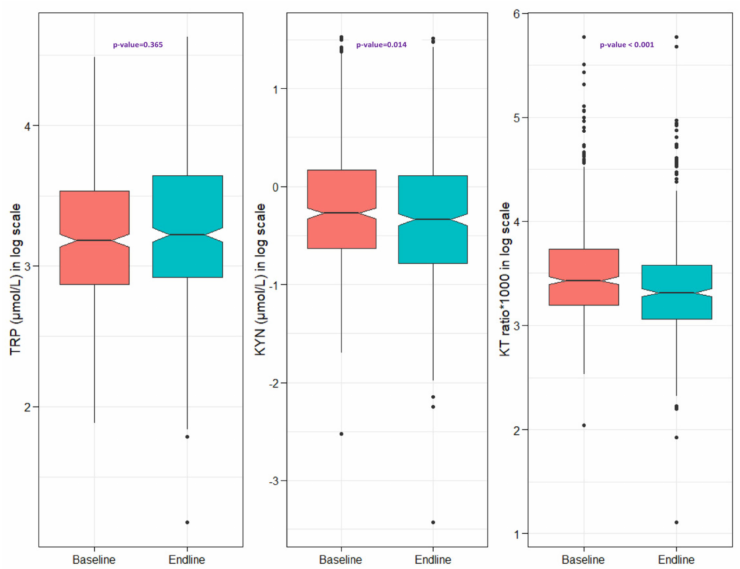
Figure 1. Baseline and endline concentrations of plasma tryptophan and kynurenine and the KT ratio in malnourished